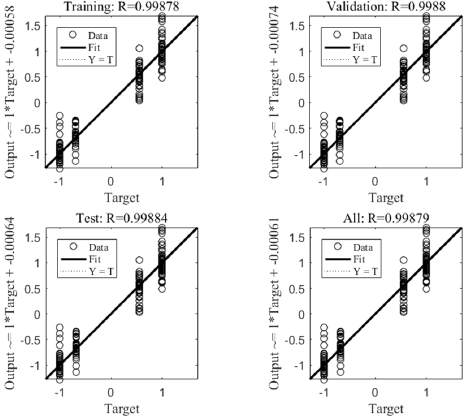
Figure 7. Deep Neural Network Training Results.